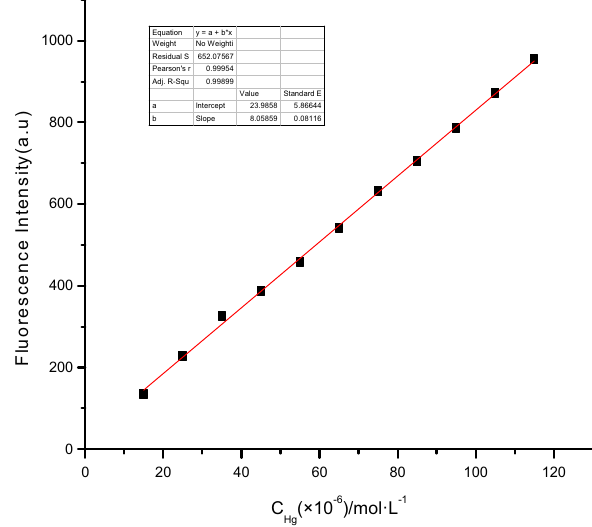
Figure 7: Standard curve of Rh - DCP detection of Hg 2 +